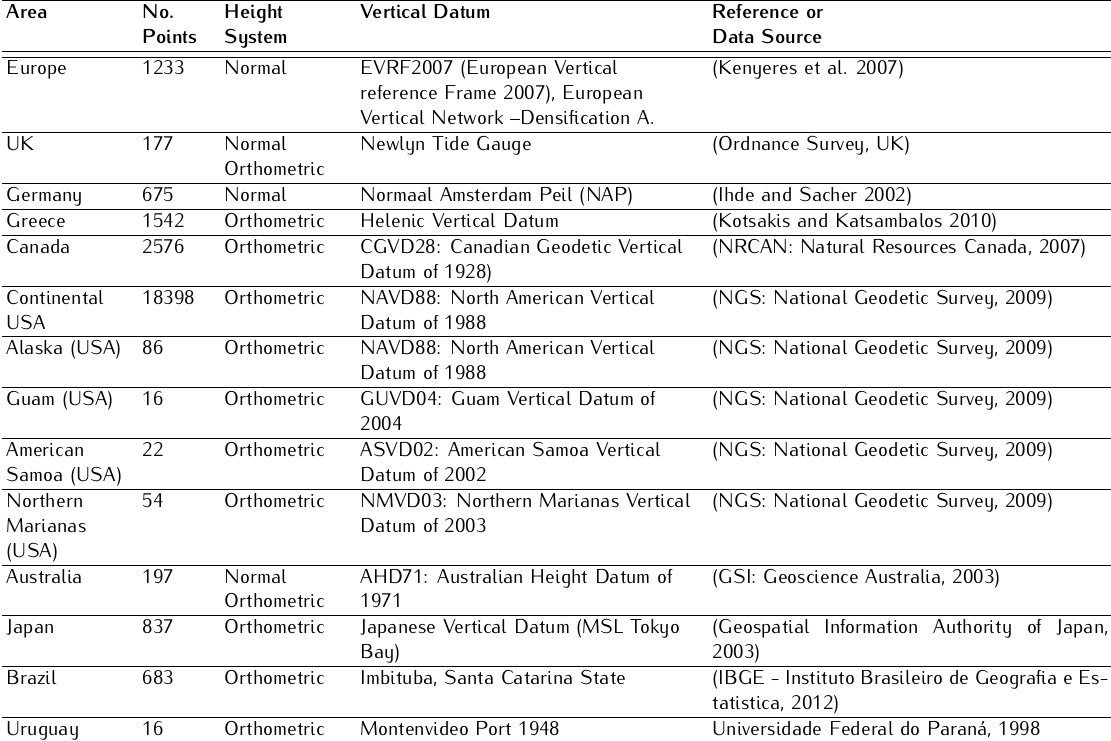
Table 2. Overview of GPS-Levelling data sets used for this study.